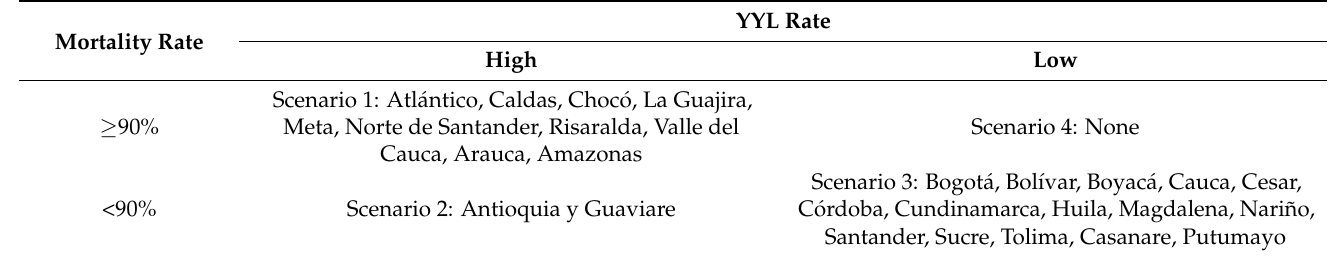
Figure A3. Georeferencing map with the epidemiological situations of tuberculosis mortality in children under 15 years of age, Colombia, 2010–2018. Table A1. Stratification in epidemiological scenarios of tuberculosis mortality, Colombia, 2010–2018.